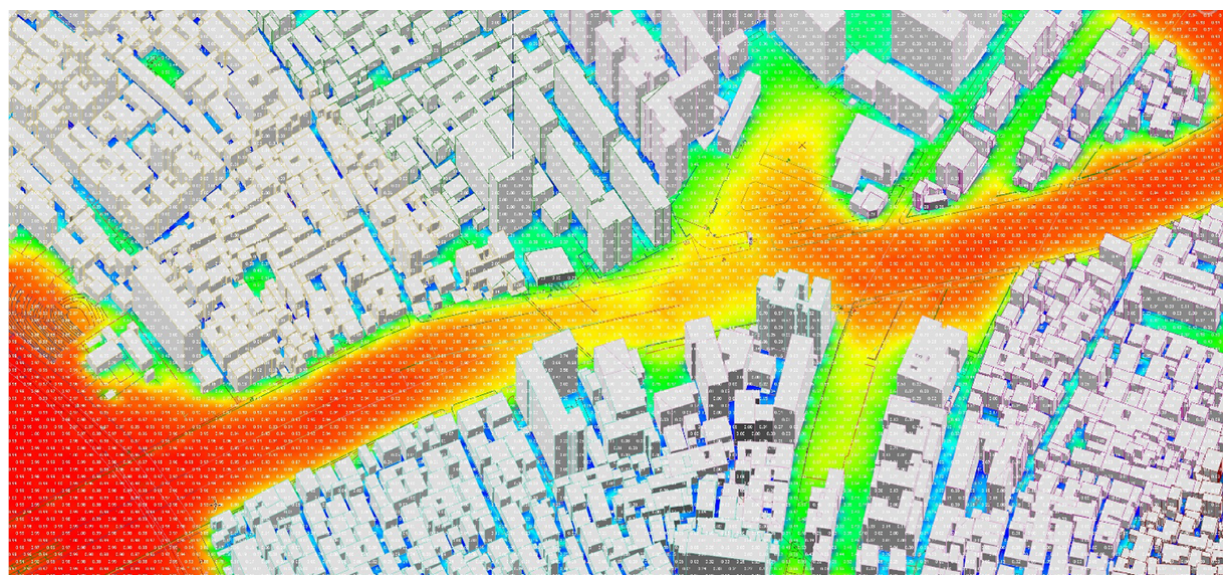
Figure 12. Detailed aerial view of the Chengnan precinct showing contrast between traditional and informal development with Soviet style slab-block